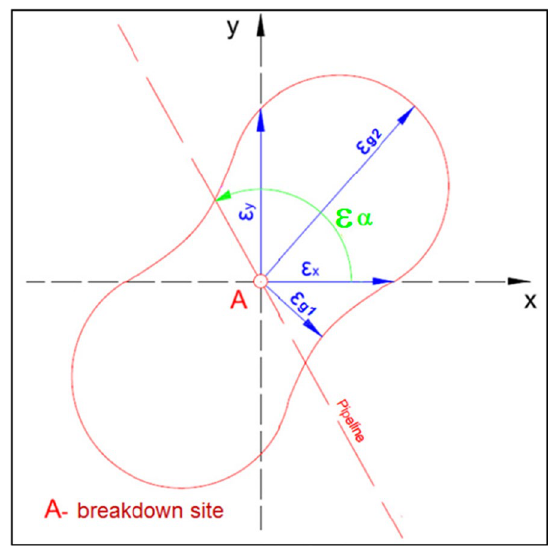
Fig. 2 Distribution of axial and principal strains at a point